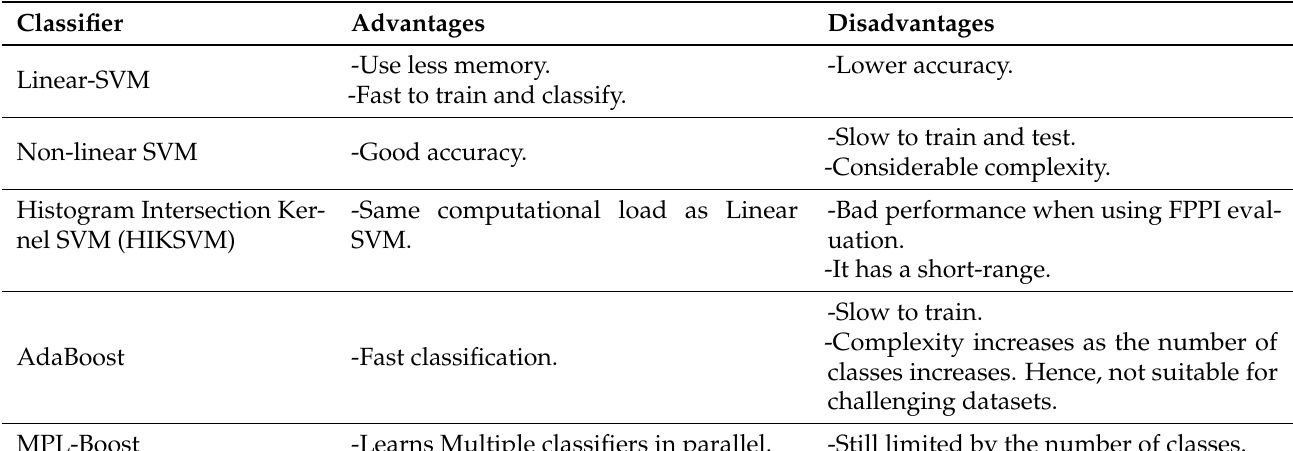
Table 3. Advantages and disadvantages of the different classifiers used in traditional